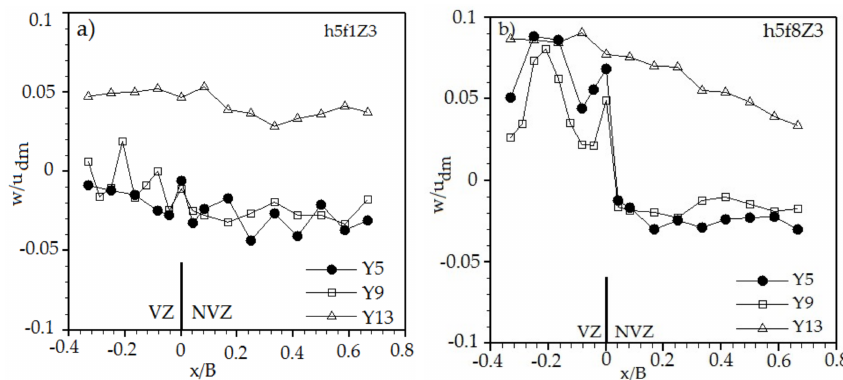
Figure 14. Non-dimensional vertical velocity distributions along the streamwise direction at z / h v = 1 for h v = 0.05 m; ( a ) φ = 0.01; ( b ) φ =